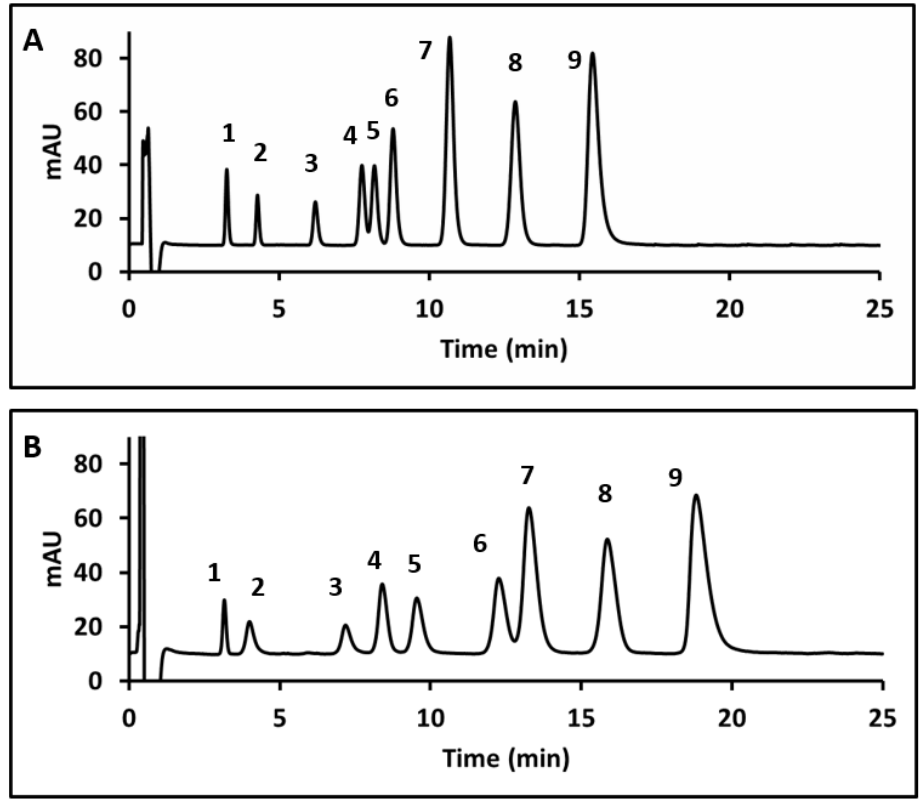
Figure 7. Chromatograms using 1% Tween 20 ( A ) and 1% Tween 40 ( B ) . Peak assignments as fol- lows: 1-CgA, 2- 3,4DHC, 3- SA, 4- FA, 5-Caf, 6- pCm, 7- mCm, 8- oCm, 9- CA. Retention times had %RSDs between 0.06% and 2.0% for Tween 20 and 0.04% and 2.8% for Tween